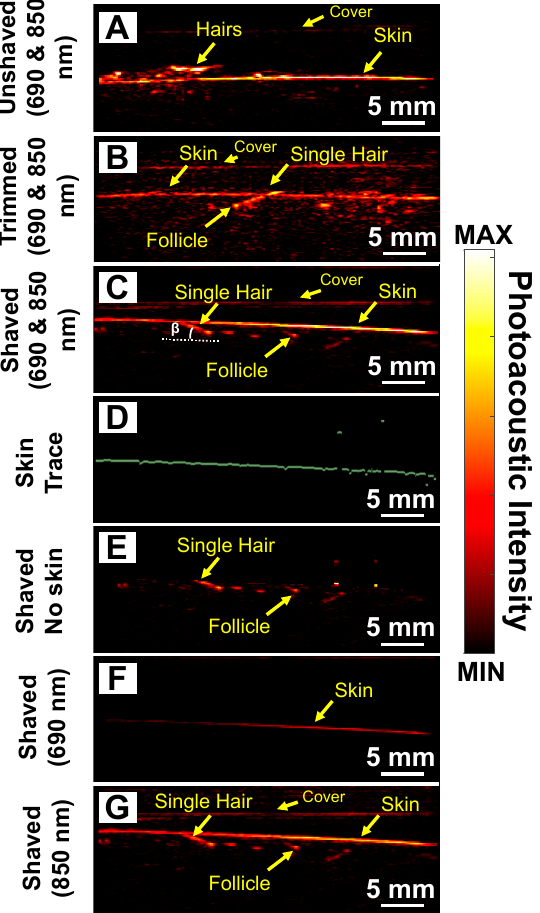
Figure 4. Subdermal imaging. Photoacoustic image of ( A ) unshaved and untrimmed, ( B ) trimmed, and ( C ) shaved abdominal skin using both wavelengths (690 and 850 nm). We could detect individual roots and subdermal hair strands using PAI after trimming and shaving. ( D ) We used a skin tracer algorithm to remove the photoacoustic contribution from the skin. ( E ) Photoacoustic image of shaved area after removing the photoacoustic signal of the skin via digital image processing. Photoacoustic image of the shaved region using ( F ) 690 and ( G ) 850 nm. Melanin in the skin absorbs strongly at 690 nm limiting depth penetration. Imaging at 850 nm allows deeper penetration allowing visualization of both the roots and subdermal strands.